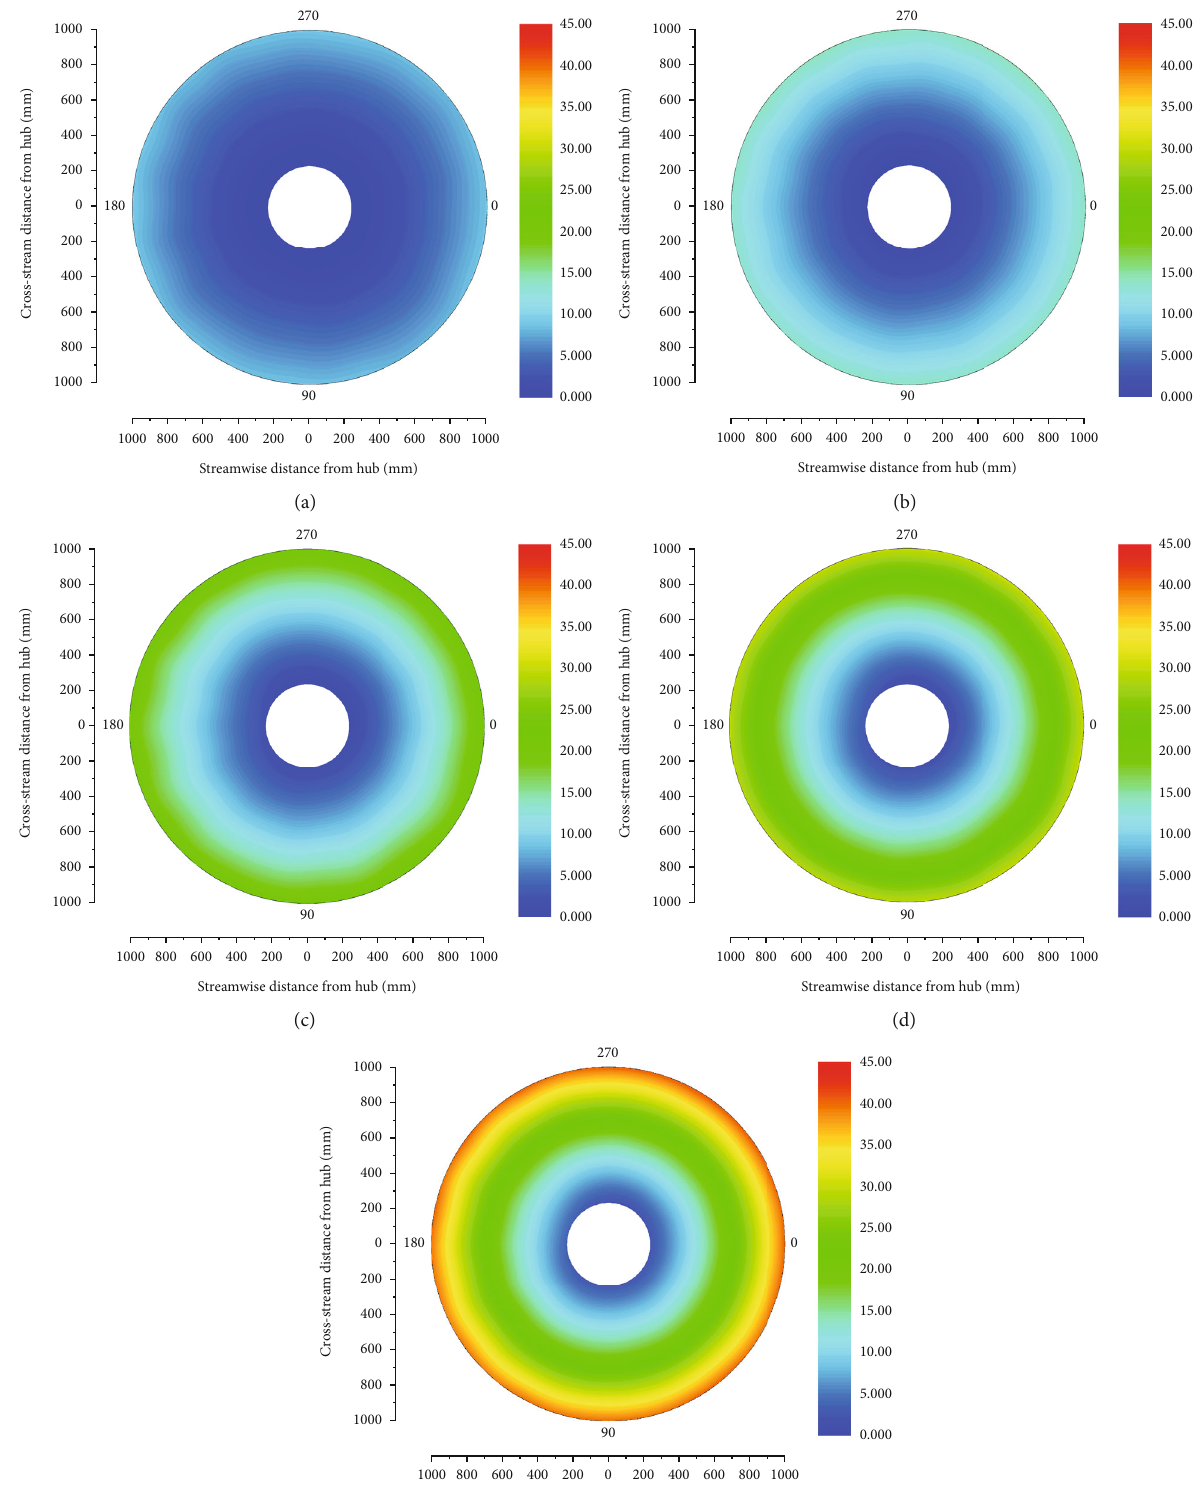
Figure 16: Blade displacements along the quarter-chord at fi ve di ff erent collective pitch angles in hover fl ight: (a) θ =0 ° ; (b) θ =2 ° ; (c) θ =4 ° ; (d) θ =6 ° ; (e) θ =8 °